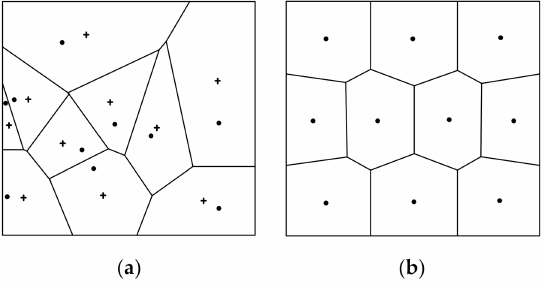
Figure 1. Schematic diagram of Voronoi cell: ( a ) VT; ( b )